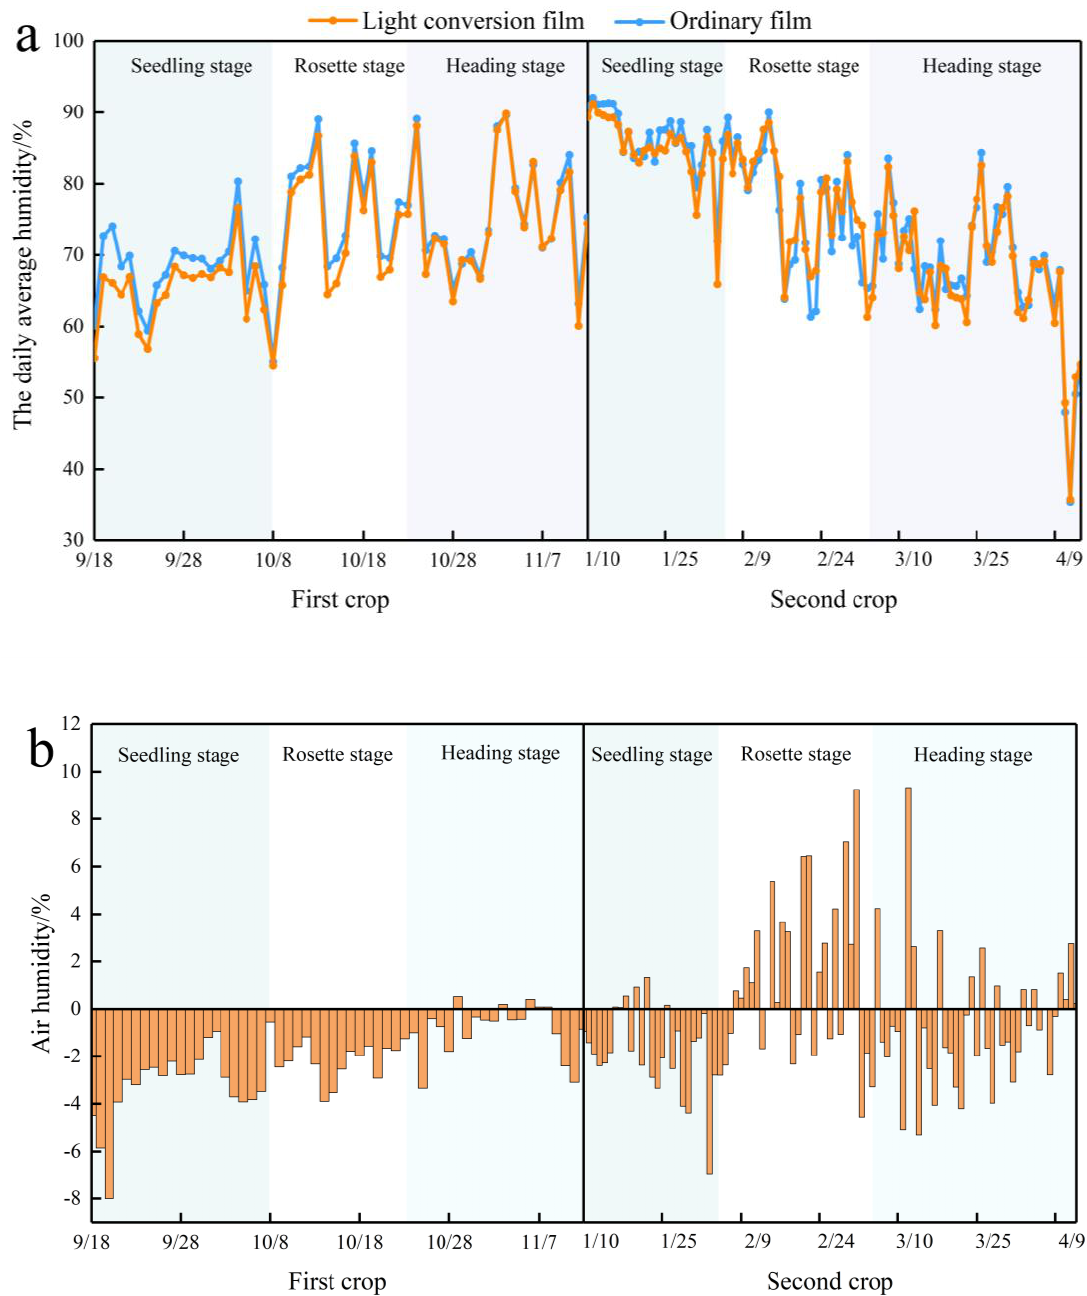
Figure 5. Effects of light conversion film (LCF) and ordinary film (OF) on air humidity in greenhouse under different crops. ( a ) Indicates the daily average air humidity change in the greenhouse environment under light conversion film and ordinary film. ( b ) Variable representing the difference between daily average air humidity of light conversion films and ordinary films.